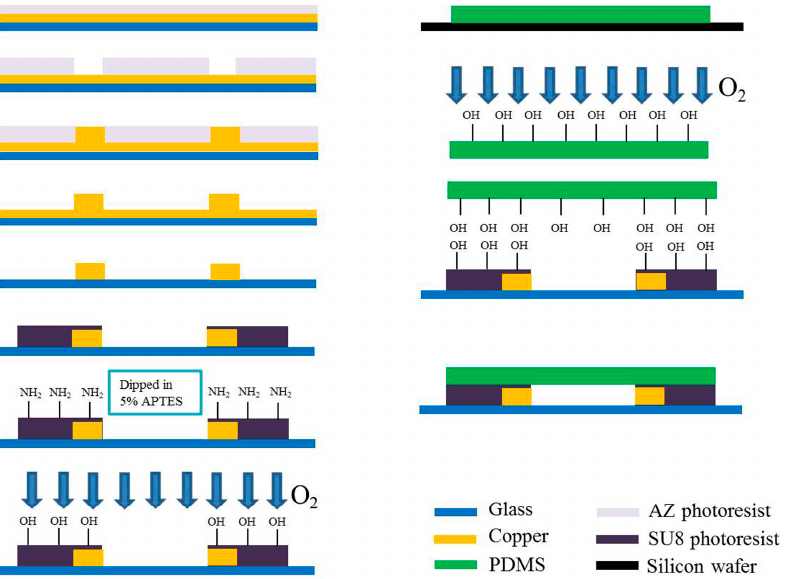
Figure 2. Fabrication process of proposed microfluidic device. The bonding principle of SU-8 with PDMS is based on the modification of Si-containing functionalities on the SU-8 surface.